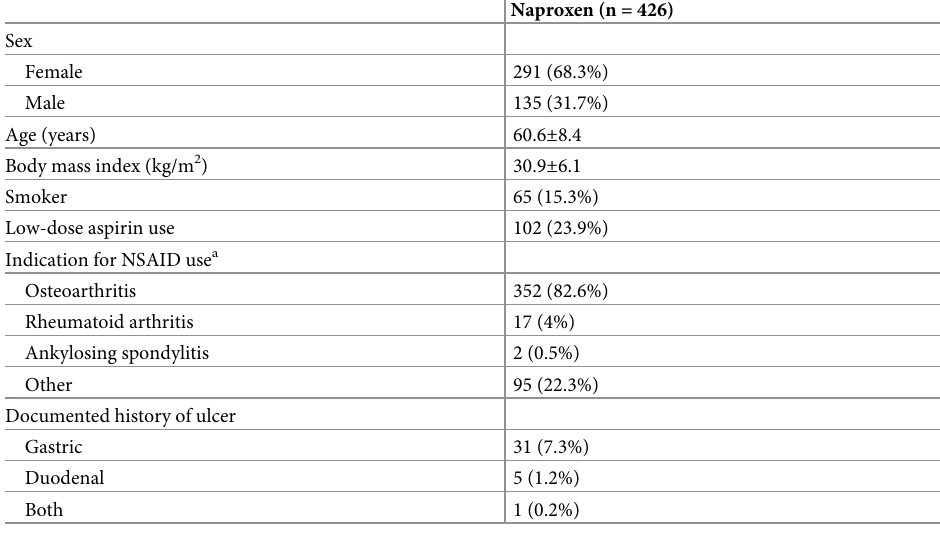
Table 1. Patient demographics and baseline characteristics of the two trial populations receiving enteric-coated naproxen (pooled data; safety set).